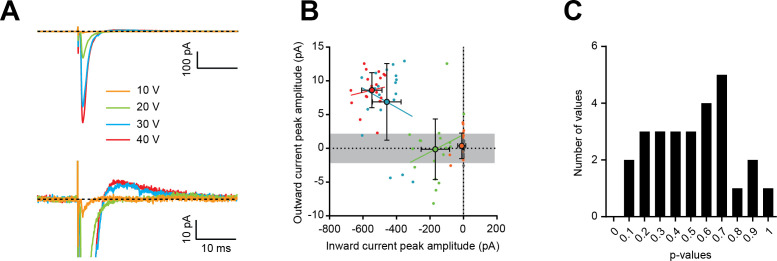
The amplitude of direct excitatory postsynaptic currents (EPSCs) and outward currents are not correlated.(A) Average compound synaptic responses recorded at a single site, and at different stimulation intensities, reveal an increase in the amplitude of both the direct EPSC (upper panel) and the secondary outward current (lower panel). (B) Outward current peak amplitude versus inward current peak amplitude of single sweeps (small dots) and their corresponding average responses (large dots) for the cell shown in A. Linear regression analysis for each stimulus condition (color-coded according to panel A) reveals that for each stimulation intensity between 20 and 40 V where a significant EPSC was detected, no correlation is observed between the peak amplitude of both components of the compound synaptic response for single sweeps (linear least squares regression analysis, 20 V: p=0.31, 30 V: p=0.38, 40 V: p=0.57). Error bars are standard deviation. (C) P-value distribution of the analysis shown in (B) for n = 27 trials (from 9 cells, one site per cell, 2 to 4 stimulation intensities per site). All p-values are above 0.05, showing no significant correlation was observed between EPSC and outward current peak amplitudes. See also Figure 1—figure supplement 1—source data 1.Figure 1—figure supplement 1—source data 1.The amplitude of direct EPSCs and outward currents are not correlated.